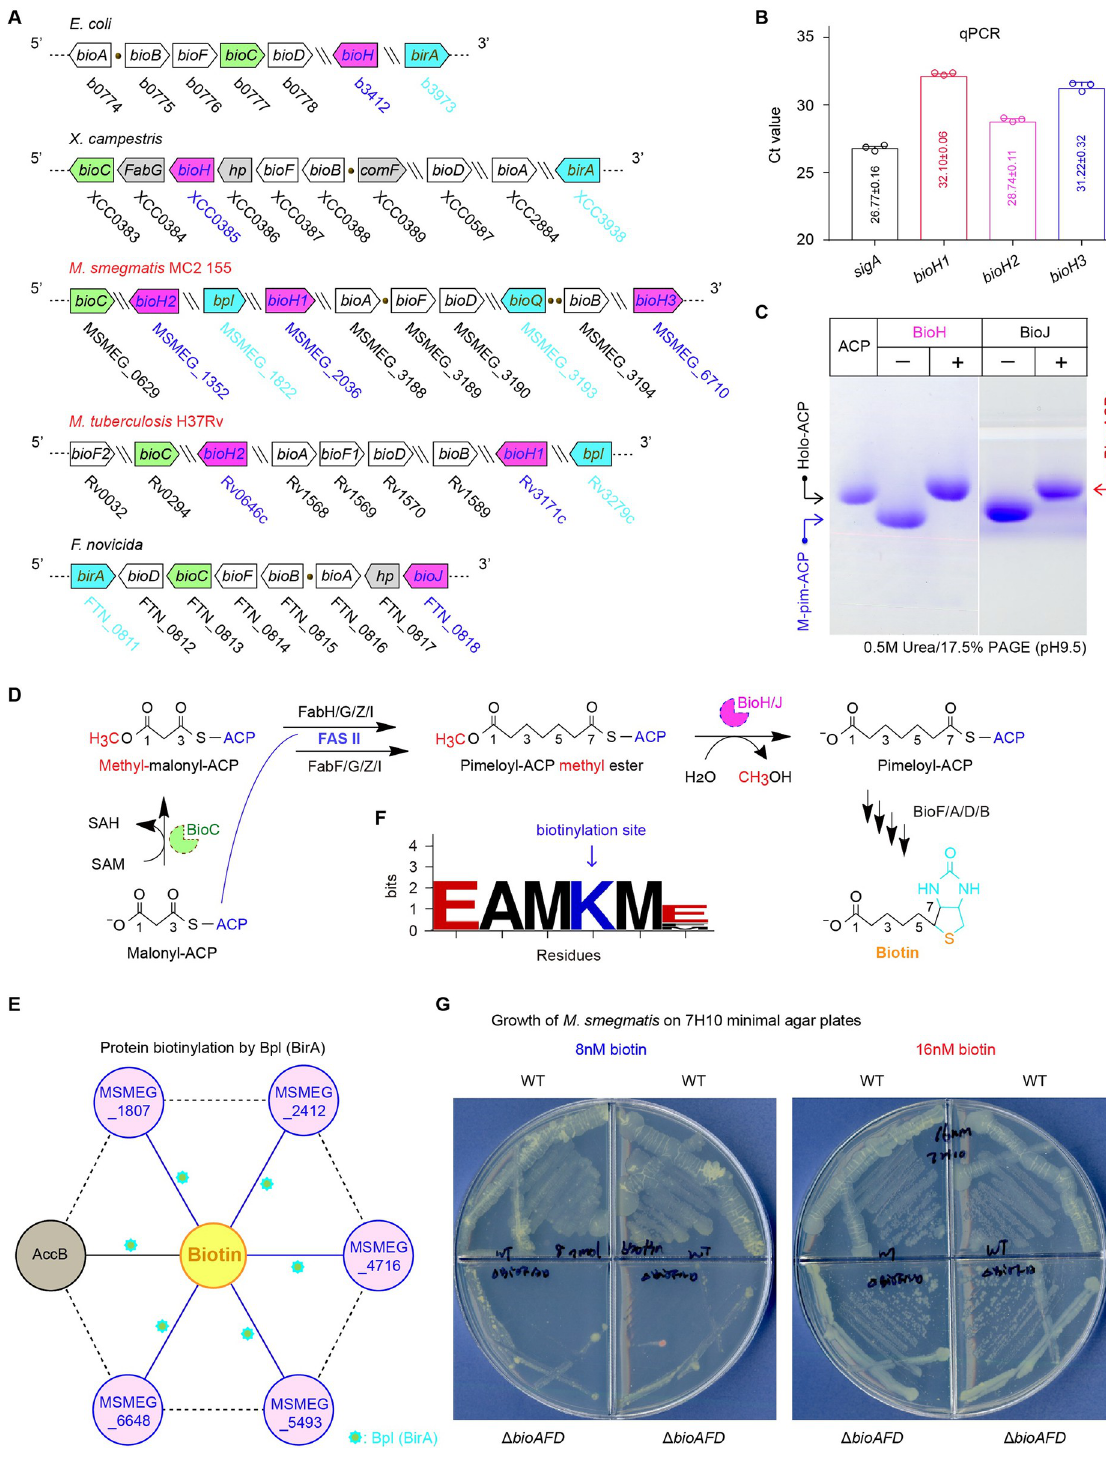
Fig 1. Scheme for BioH action in mycobacterial biotin biosynthetic pathway. A. Genetic environment of bioH homologs in different microorganisms. The dots denote the conserved sequence motifs recognized by the regulatory protein (e.g., BirA and/or BioQ, shown in cyan background). The two discontinued loci are separated with the double slash. The bioC is colored green, and the bioH homolog is highlighted in purple. B. Real-time quantitative PCR (qPCR) analysis for expression of three putative BioH paralogs ( bioH1 to bioH3 ) Namely, the three bioH isoforms included bioH1 (MSMEG_2036), bioH2 (MSMEG_1352), and bioH3 (MSMEG_6710). sigA encoding